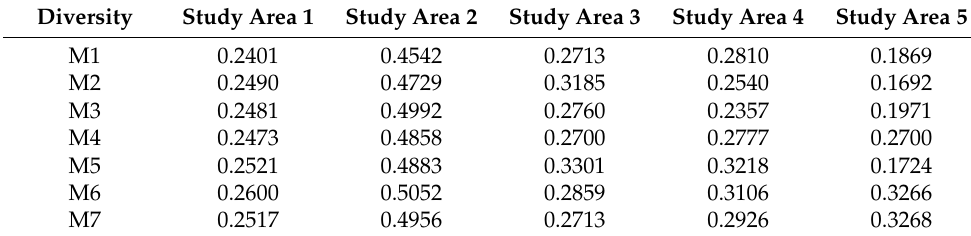
Table 4. Diversity of each sample